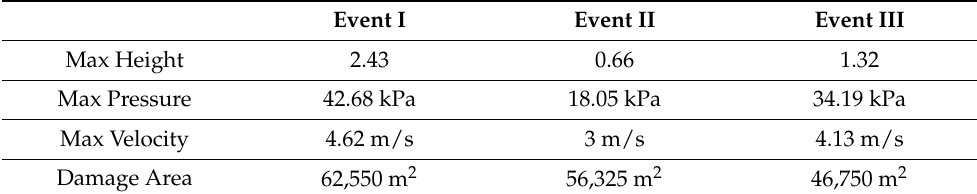
Table 3. Debris Flow Simulation Results Using the RAMMS Model.